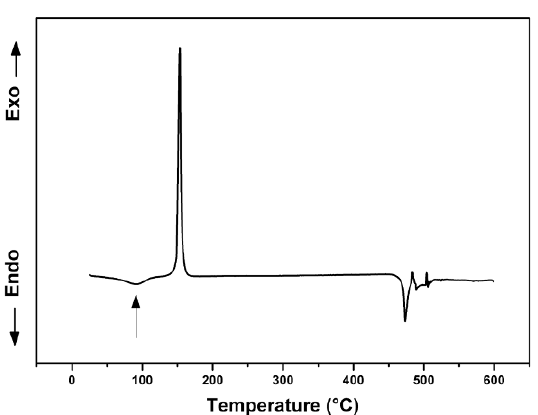
wavenumber range of 400 – 1200 cm –1 .